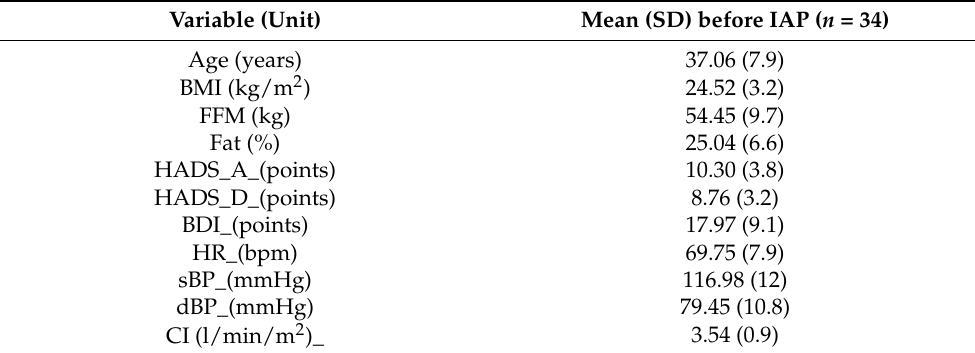
Table 1. Patients’ characteristics before Individualised Activity Program